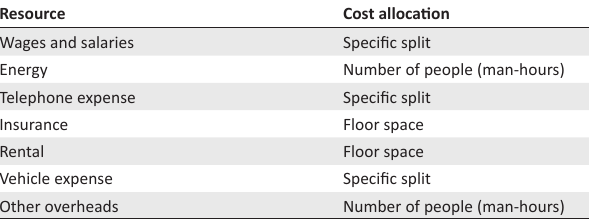
TABLE 2: Resource cost allocation